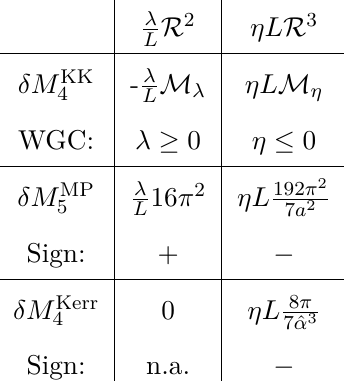
− ≥ 0 are given in (3.13). Imposing that ( λ,η )